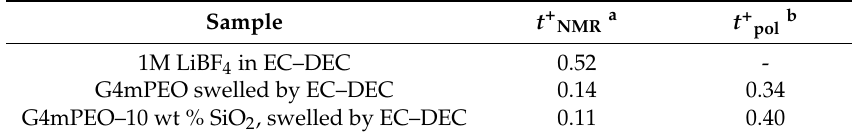
Table 4. Transference number of gel electrolyte membranes. Adapted from Aihara et al.